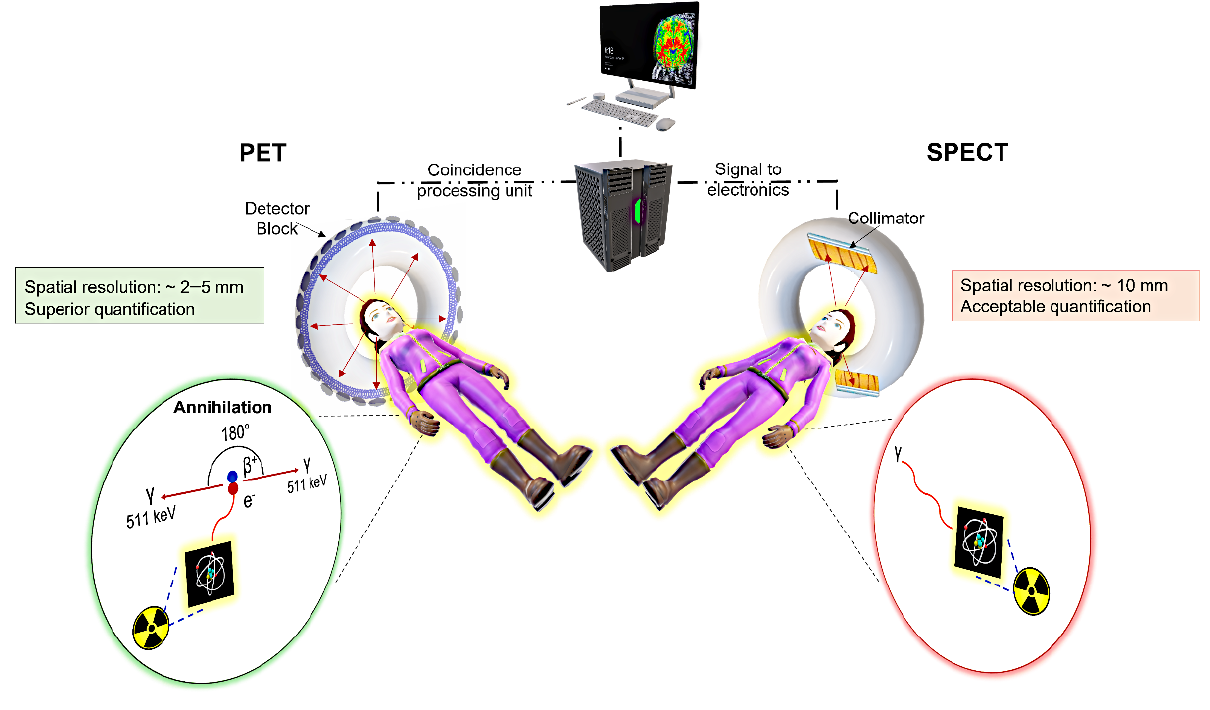
Figure 1. Depiction of PET and SPECT imaging.